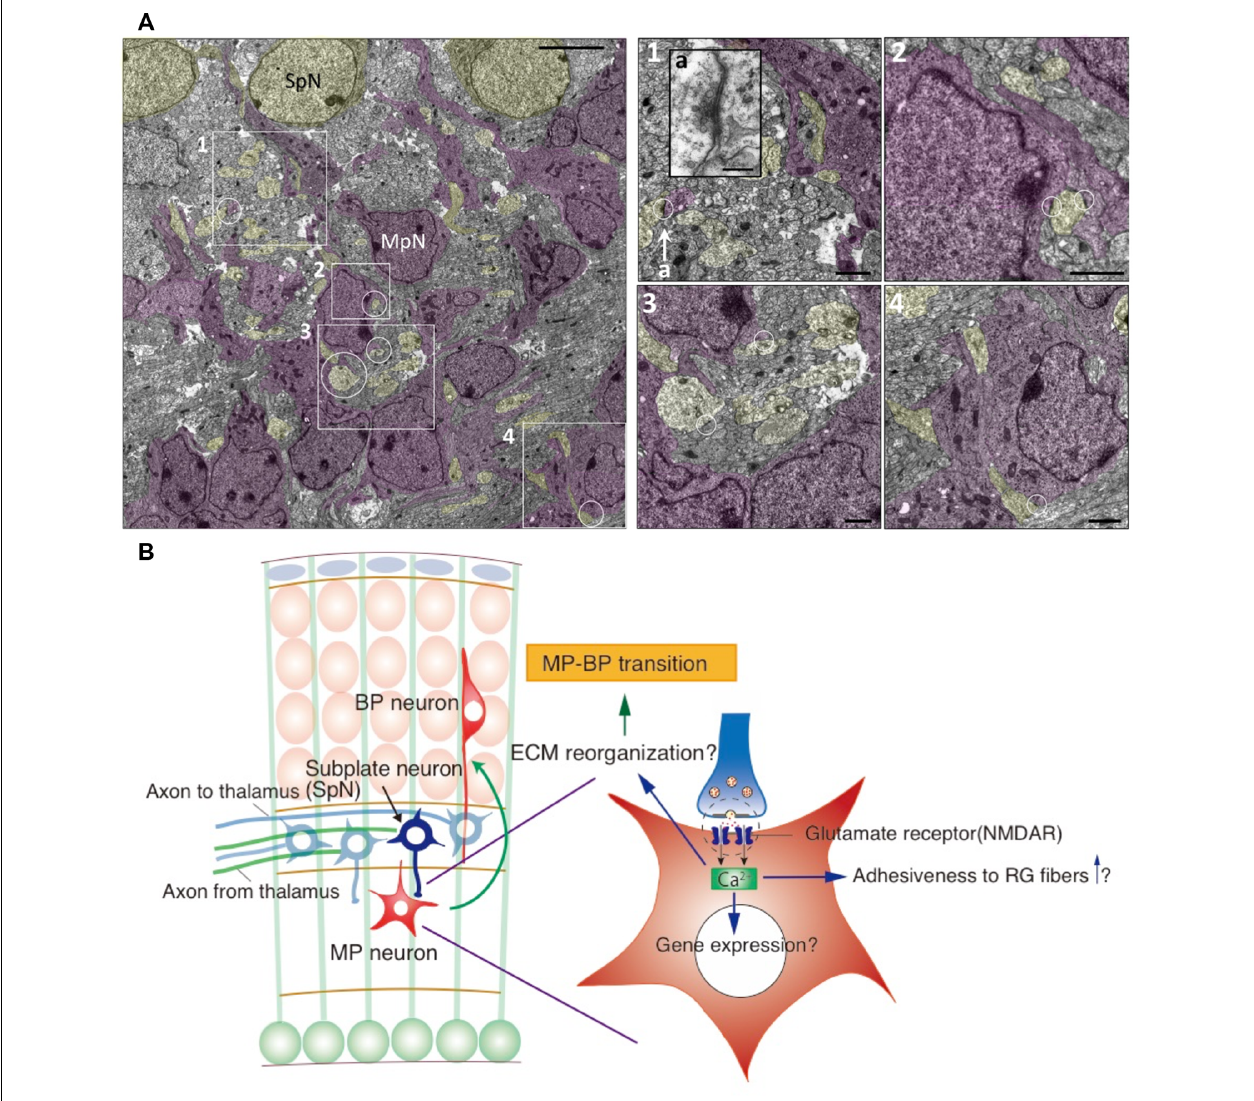
FIGURE 2 | Synaptic interaction between SpNs and MpNs is found just below the subplate layer. (A) Electron microscopic images of synapses on MpNs in the E16 cortical section. The areas indicated by the rectangles and circles are enlarged in the right. Synapse located in 1-a is enlarged as an inset. Scale bars, 50 µ m for the left image, 200 nm for a, 10 µ m for 1–4. (B) Hypothetical model for the interaction between SpNs and multipolar neurons. SpNs form transient glutamatergic synapses on multipolar neurons, which induce a Ca 2+ influx in multipolar neurons through the NMDA receptor. Calcium signaling may alter gene expressions involved in cytoskeletal remodeling and cell adhesiveness, leading to multipolar-to-bipolar transition (Ohtaka-Maruyama et al., 2018).